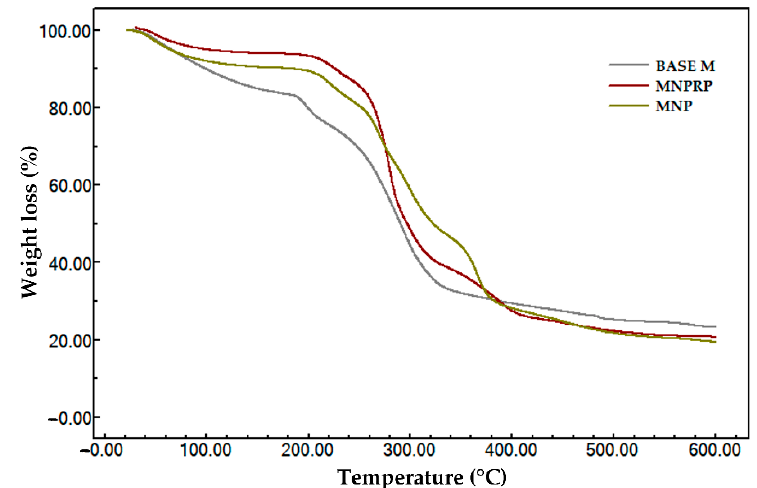
Figure 7. Thermogravimetric profile of membrane: Base M (membrane without propolis and nanoparticles), MNP, and MNPRP. Table 6. Thermogravimetric events of Base M, MNP, and